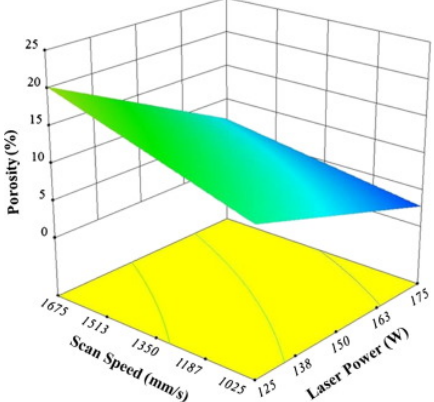
Figure 35. Response surface plot showing the effect of the laser power and the laser scan speed on the porosity level at a constant hatch spacing (0.5 µm) and island size (5 mm) [166]. Copyright 2014. Adapted with permission from Elsevier Science Ltd. under the license number 4803731023945 (Figure 4 [166]), dated 7 April